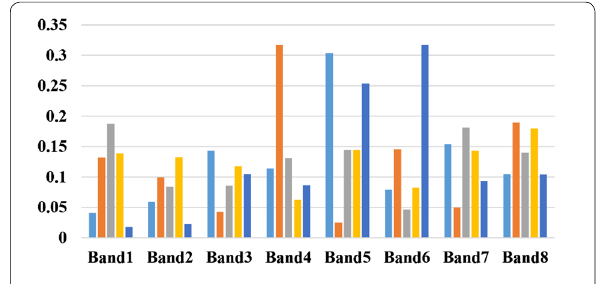
Figure 4 Energy distribution of different condition